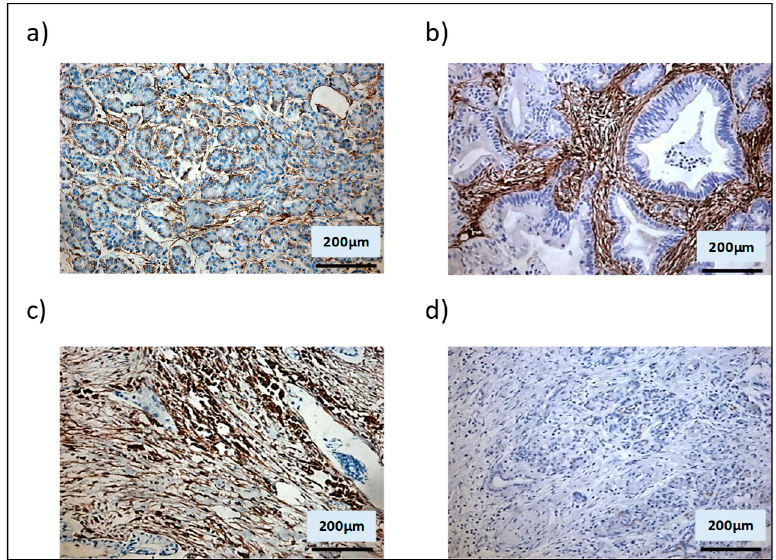
( d ) negative control demonstrates absence of staining either in MDT tissue when an isotype control antibody was substituted for the specific antibody to the target. Red arrows and black arrows indicate epithelial and stromal cancer cells expressing Shh, respectively. Semi-quantitative analysis of the percentage Shh staining in the epithelial ( e ) and stromal ( f ) compartments in all tumour samples (* p < 0.05 Kruskal-Wallis multiple comparison Test).